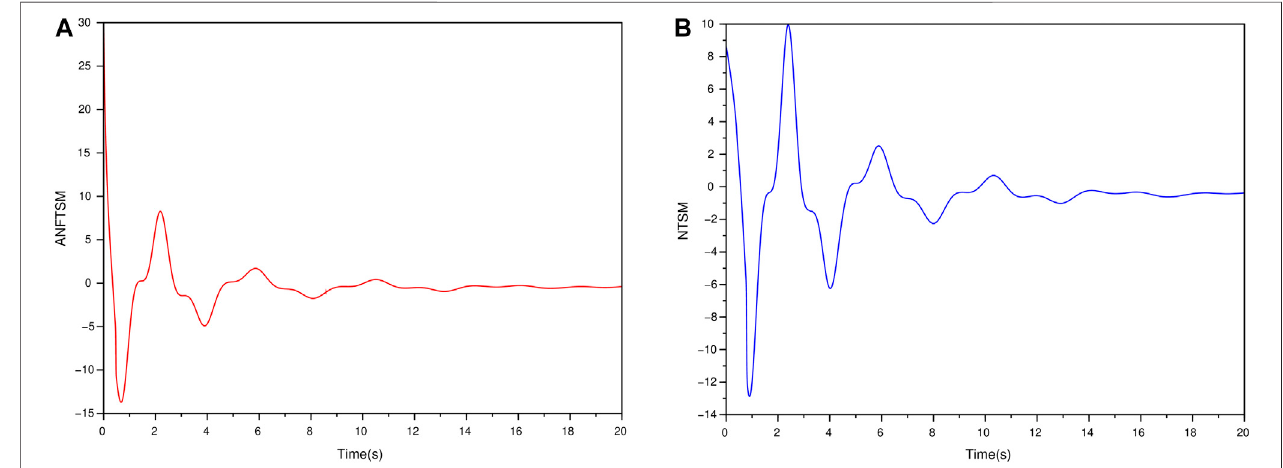
FIGURE 11 | The time response of the design controller u ( t ) in Example 2 (A) ANFTSM controller (B) NTSM controller.